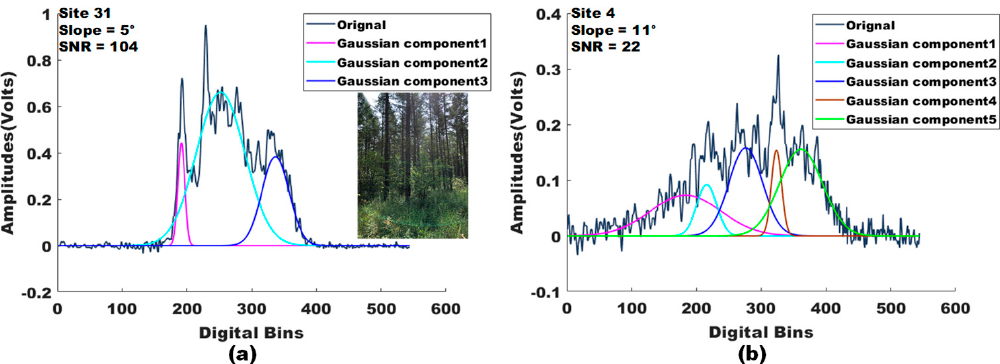
Figure 7. Two GLAS received waveforms corresponding to forest-covered footprints. ( a ) A GLAS received waveform corresponds to the forest with a multilayer distribution canopy. ( b ) A GLAS received waveform with a low signal-to-noise ratio.